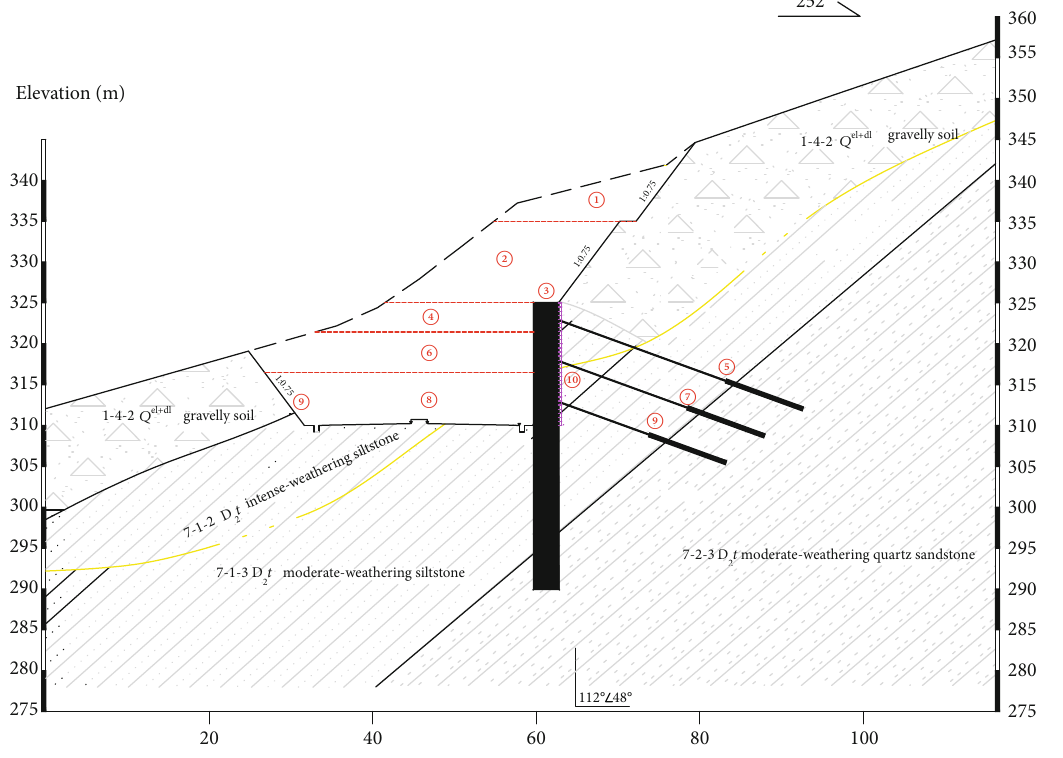
Figure 7: Suggested rational construction steps. Table 1: Climate of Yanling County before the